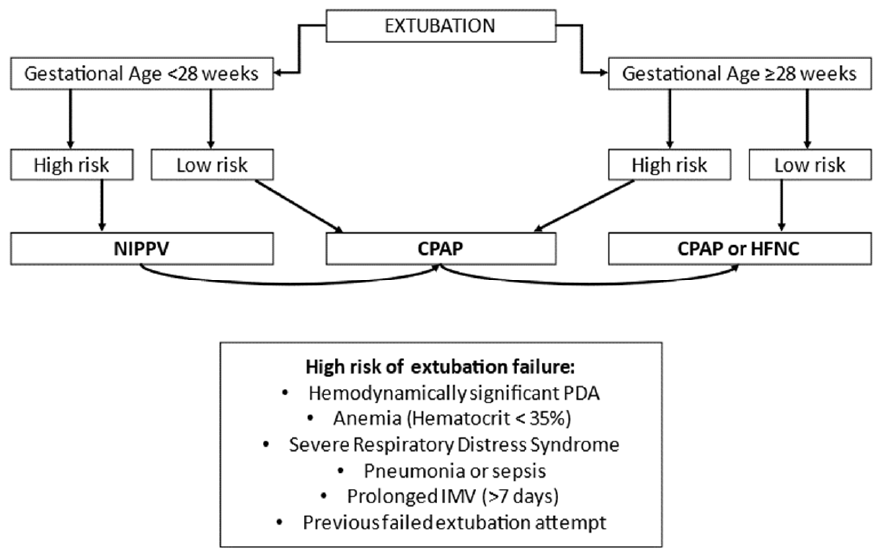
Figure 2. Proposed algorithm for choosing post-extubation noninvasive support modality. NIPPV: Nasal Intermittent Positive Pressure Ventilation, CPAP: Nasal continuous positive airway pressure, HFNC: High-Flow Nasal Cannula, PDA: Patent ductus arteriosus, IMV: Invasive mechanical